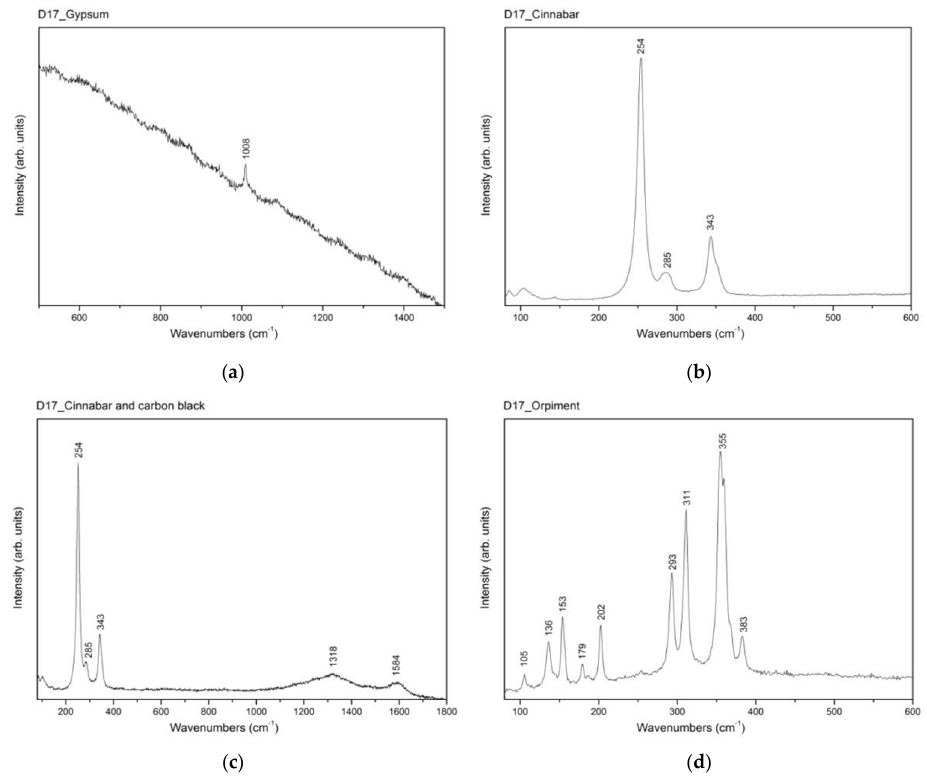
Figure 5. Four Raman spectra, which led to the identification of pigments and the gesso ground in the sample cross sections D17 (Figure 2a,b), are included as examples. In particular, the following were identified: ( a ) gypsum, ( b ) cinnabar, ( c ) carbon black with cinnabar, and ( d ) orpiment.